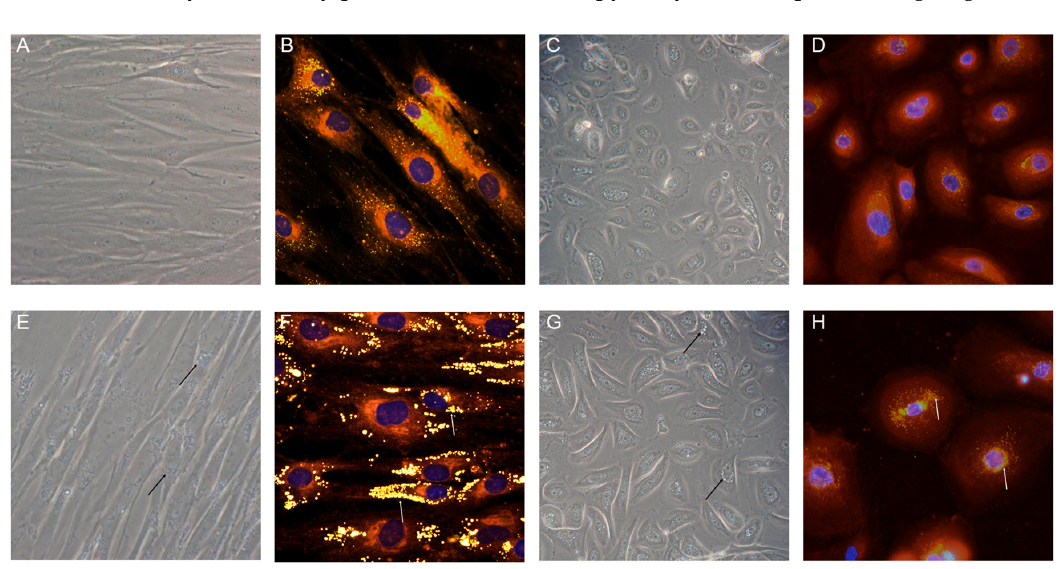
Figure 6. LD images obtained from NLSDI skin cells. Phase-contrast images of cultured fibroblasts and keratinocytes from control ( A , C ) and affected subjects ( E , G ); fluorescent microscopy images with Nile Red and DAPI staining of fibroblasts and keratinocytes from normal ( B , D ) and NLSDI ( F , H ) subjects. LDs are indicated by arrows. Phase-contrast images: magnification 20×; fluorescent microscopy images: magnification 40×.